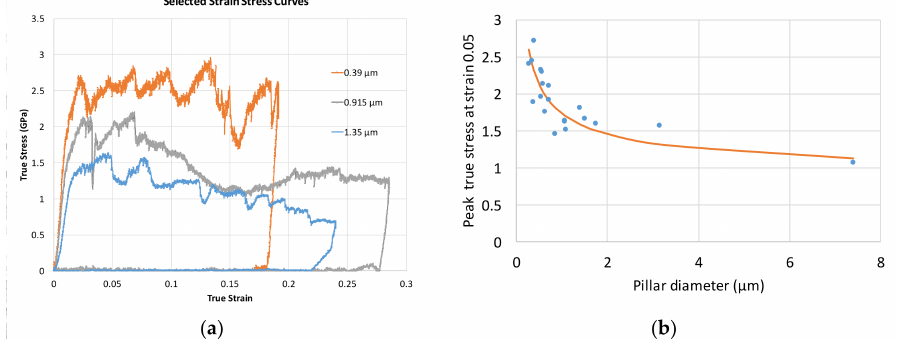
Figure 4. ( a ) Typical stress–strain curves for pillars of different diameters; ( b ) plot of true flow stress at 0.05 true compressive strain for all tested pillars, and fit to the data according to Equation